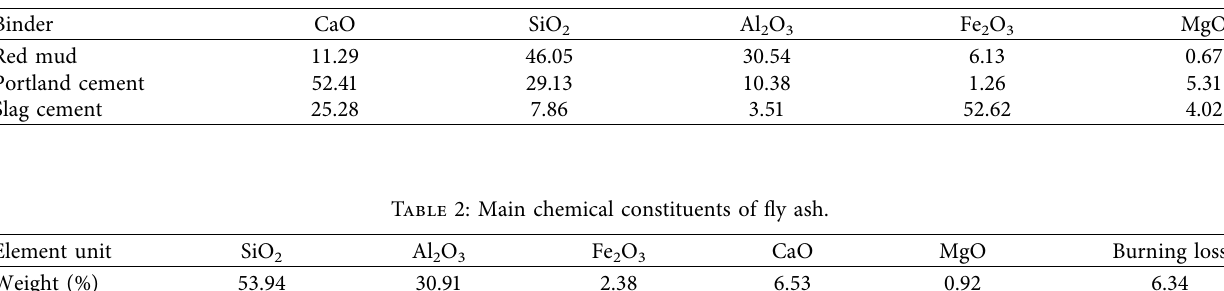
Figure 1: Three types of binders: (a) red mud, (b) Portland cement, and (c) slag cement. Table 1: Main chemical constituents of binders (in % weight).